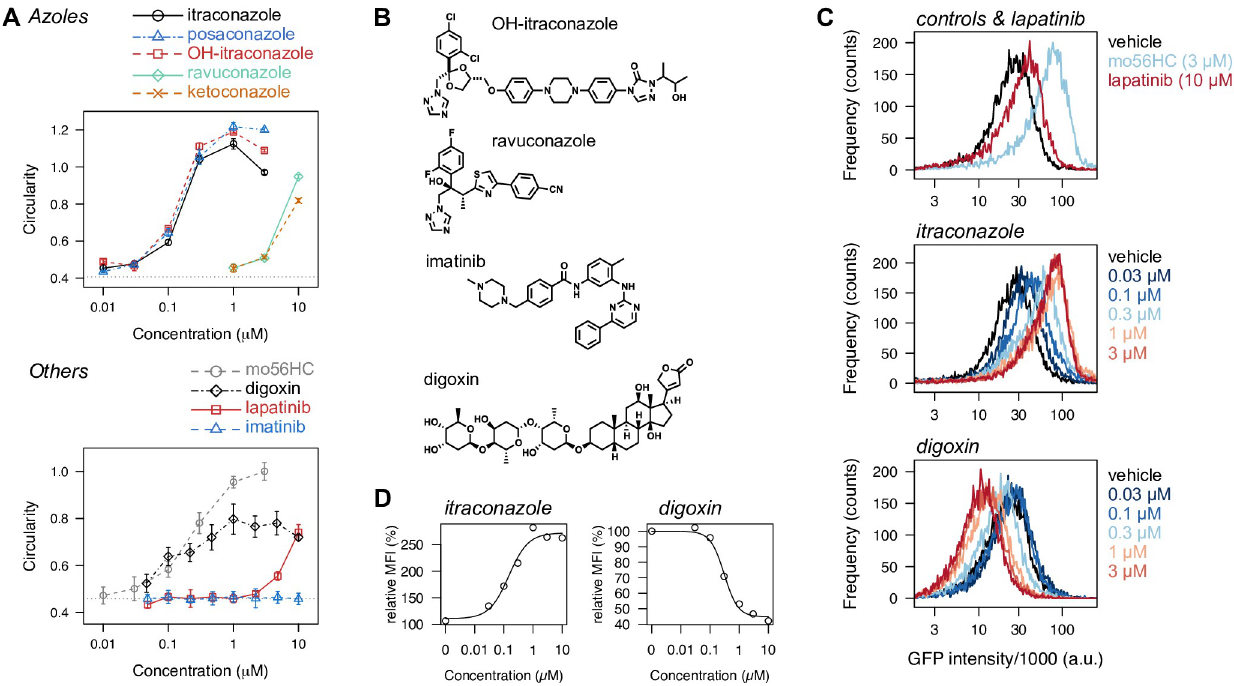
Fig 3. Validation of the hits by dose-response analysis and flow-cytometric analysis. (A) Dose-response analysis of the hits and related compounds. (B) Chemical structures of the compounds used in (A) and not shown in Fig 2. (C) Stabilizing effect of the hits on the NPC1 mutant, examined by flow- cytometric analysis. Cells stably expressing NPC1-I1061T-GFP were treated as indicated for 21 h, and processed for flow-cytometric analysis to quantify the steady-state expression level of the mutant protein. Consistent with the stabilizing effect of mo56HC (upper panel), lapatinib (upper panel) and itraconazole (middle panel) both stabilized the mutant protein. (D) Dose-dependent increase in the mean GFP fluorescence intensity from the flow-cytometric data shown in (C). Itraconazole (left panel) increased the NPC1-I1061T-GFP level approximately 270% with an EC 50 of 0.15 μ M, and digoxin (right panel) reduced the expression level to 45% with an EC 50 of 0.31 μ